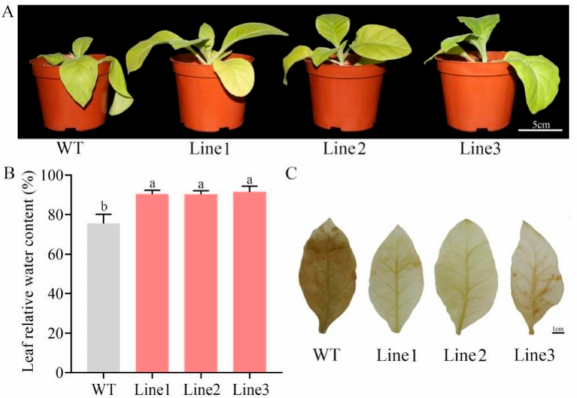
Figure 6. Phenotype and stress physiological indices of WT and transgenic lines under drought stress. ( A ) Phenotype of WT and transgenic lines under drought stress; ( B ) Relative leaf water content; ( C ) H 2 O 2 accumulation was detected by DAB staining. Tobacco plants were stressed by drought for 10 days. The values represent the mean ± SD, and different letters indicate significant differences according to Duncan’s multiple range test ( p <